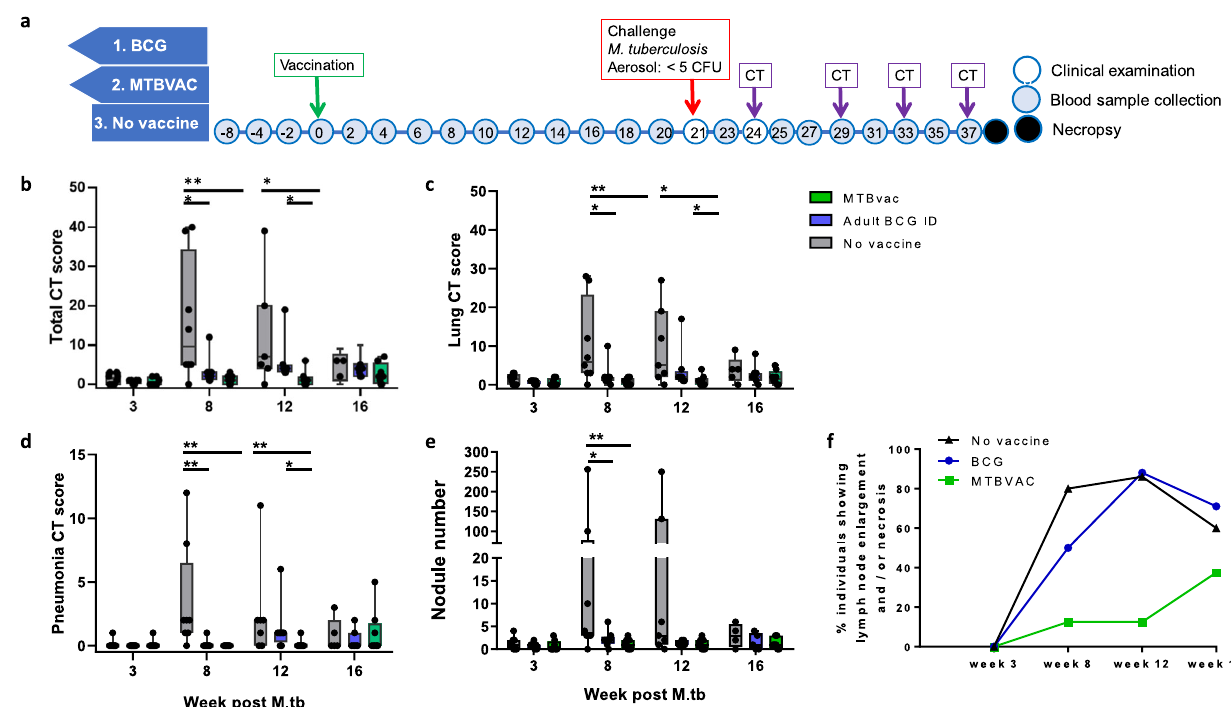
Fig. 1 Study schedule and in vivo CT imaging. a Diagram showing the week in which clinical examinations (open circle), blood sample collections (shaded circle), CT scan collection, the aerosol challenge with M. tuberculosis and necropsy (black circle) were conducted relative to vaccination. Disease burden development quanti fi ed from CT scans re fl ects scores derived for total disease burden ( b ), pulmonary disease burden ( c ), pneumonia ( d ) and the number of TB-induced nodules in the lung ( e ) from CT scans collected eat weeks 3, 8, 12 and 16 after challenge with M. tuberculosis . Box plots show group median values + / − IQR with minimum and maximum values indicated by box whiskers. f Incidence of lymph node disease across the 16-week study period. Non-parametric Mann – Whitney U tests were used for comparison between groups with unadjusted results reported as: * P ≤ 0.05; **P ≤